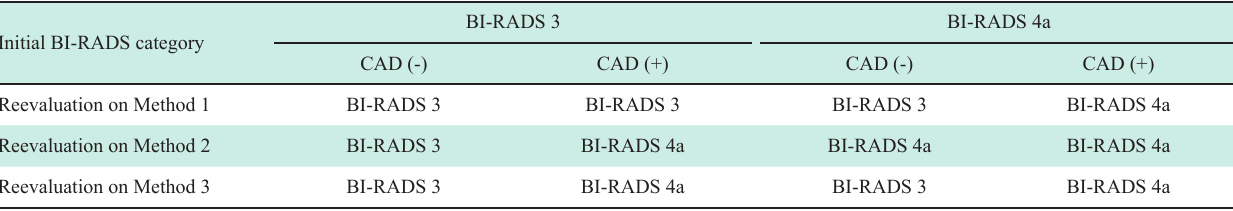
Table 1 The combined methods of CAD with breast imaging reporting and data system (BI-RADS) in the diagnosis of breast lesions Initial BI-RADS